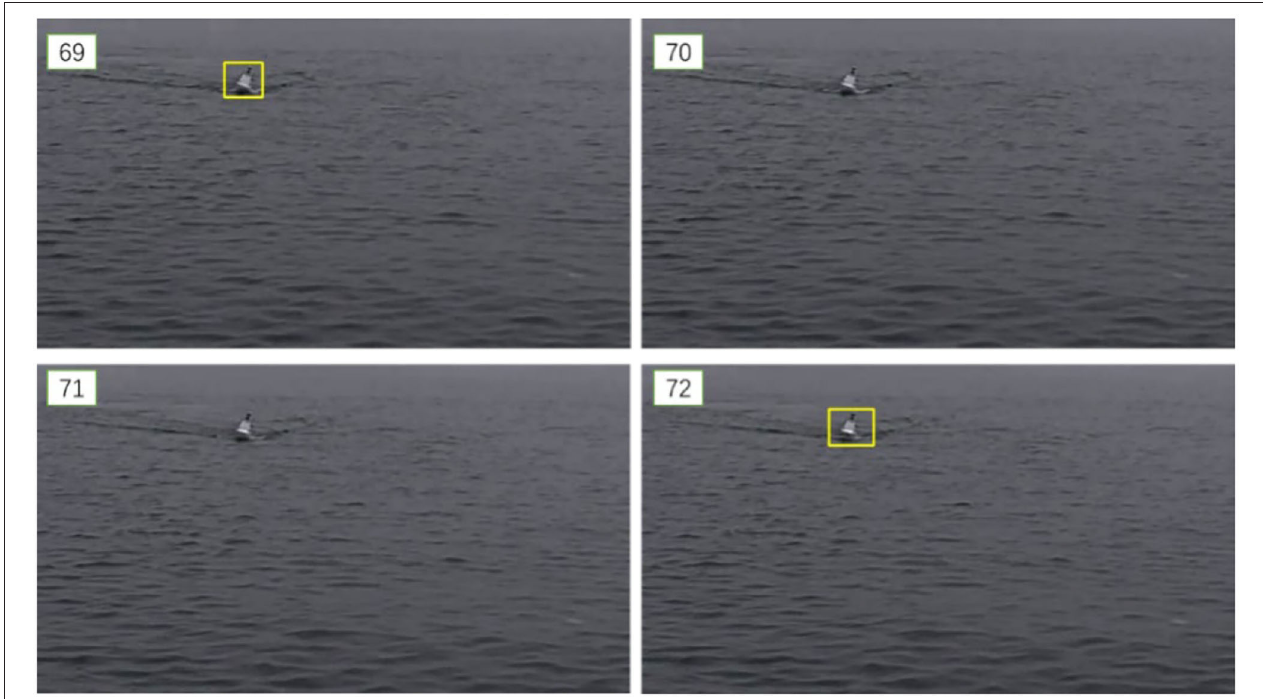
FIGURE 7 | Missed detection